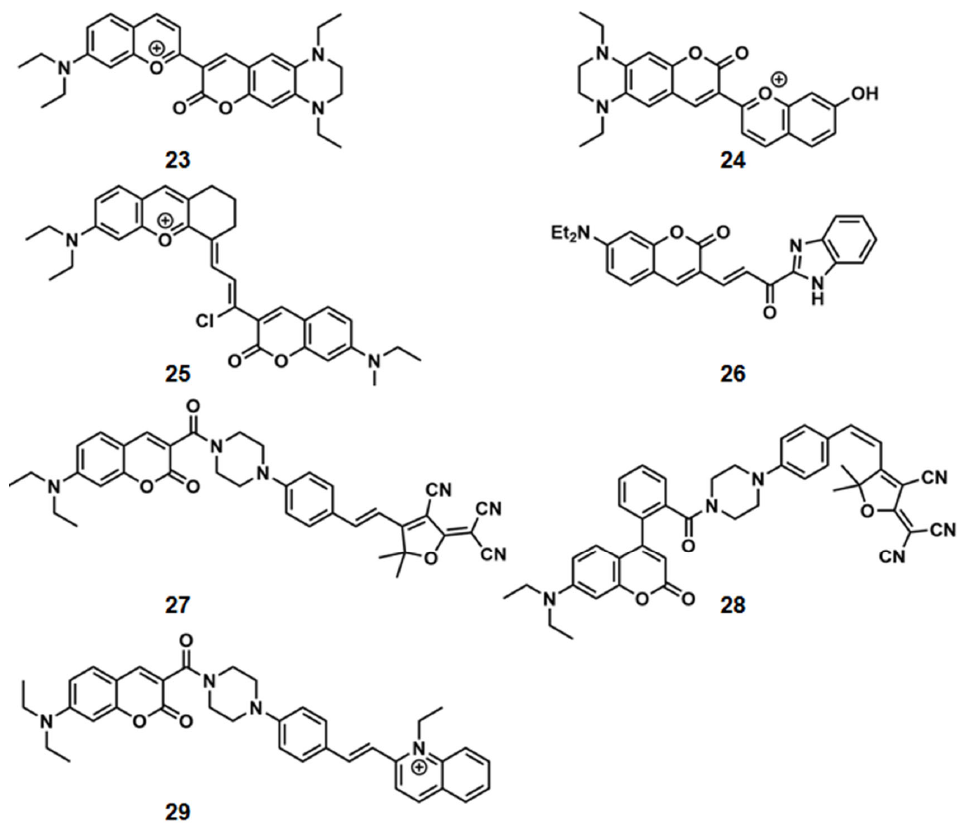
Scheme 7. The framework of sulfite fluorescent probes 23 − 29